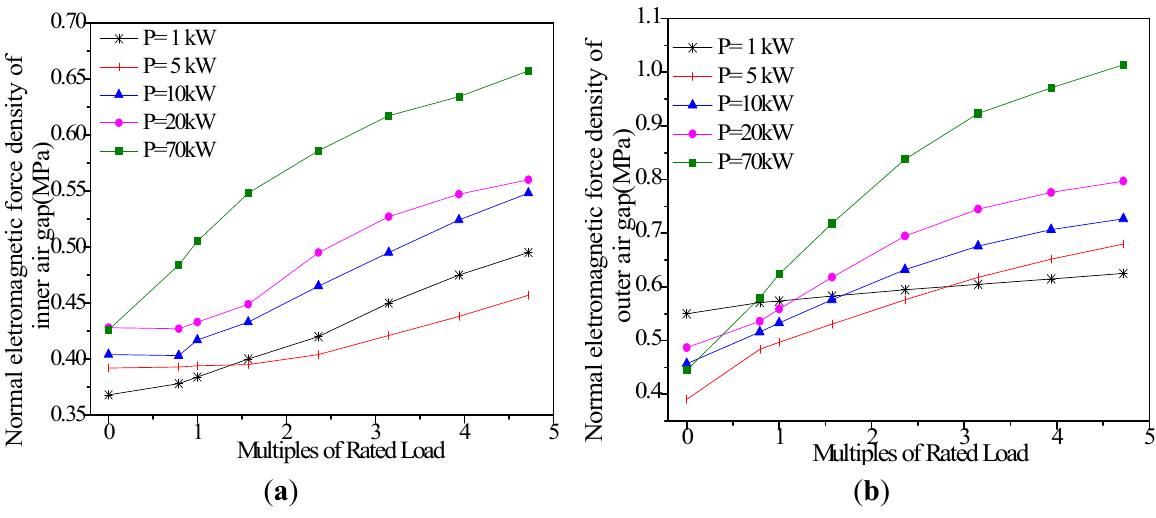
Figure 17. The maximum normal electromagnetic force density of five different power level DRPMSMs: ( a ) inner air gap; ( b ) outer air